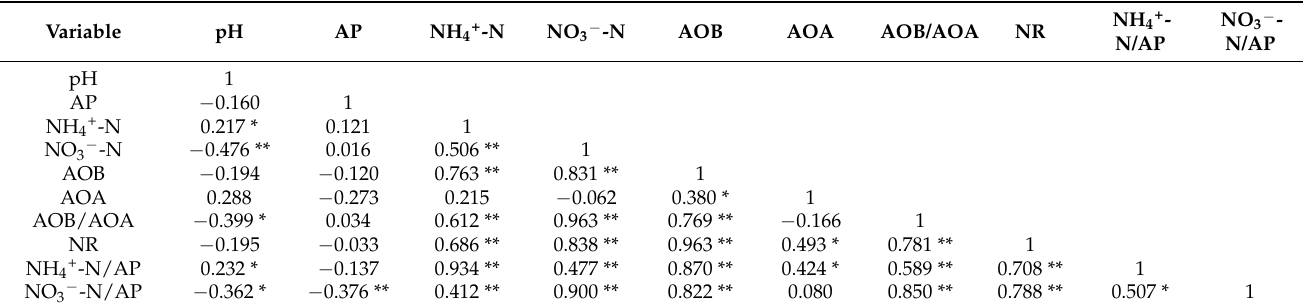
Table 4. The correlation coefficients between ammonia-oxidizing microorganisms and soil properties.